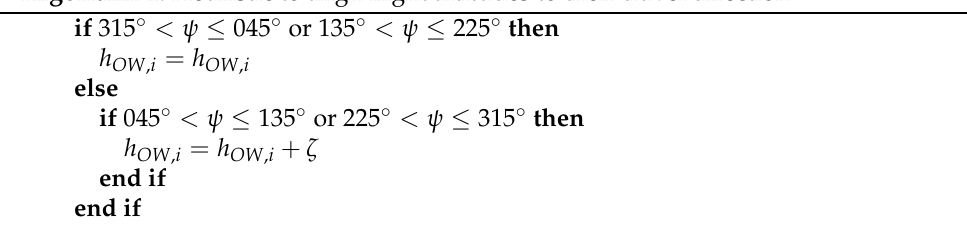
Algorithm 1: Heuristic to align flight altitudes to their travel direction.